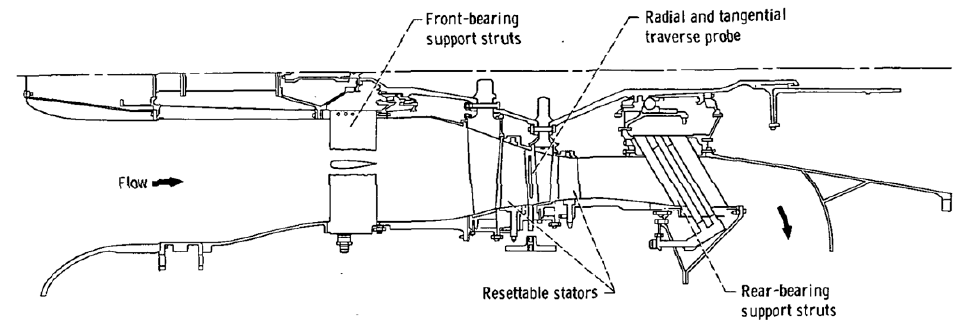
Figure 1. Schematic of two-stage fan test arrangement [13] .